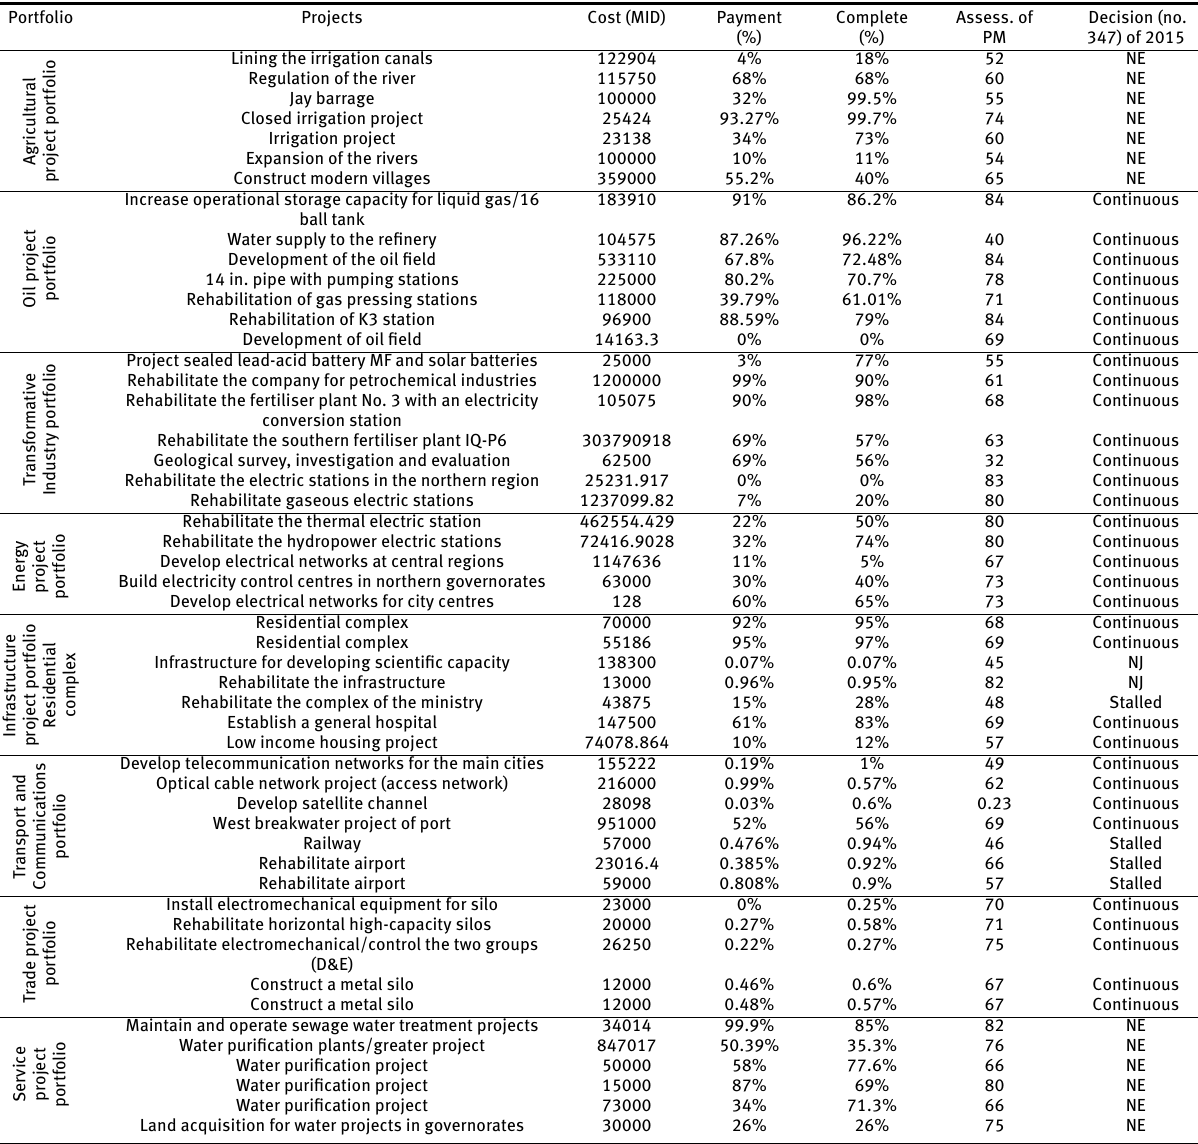
Table 10: Results of the Studied projects